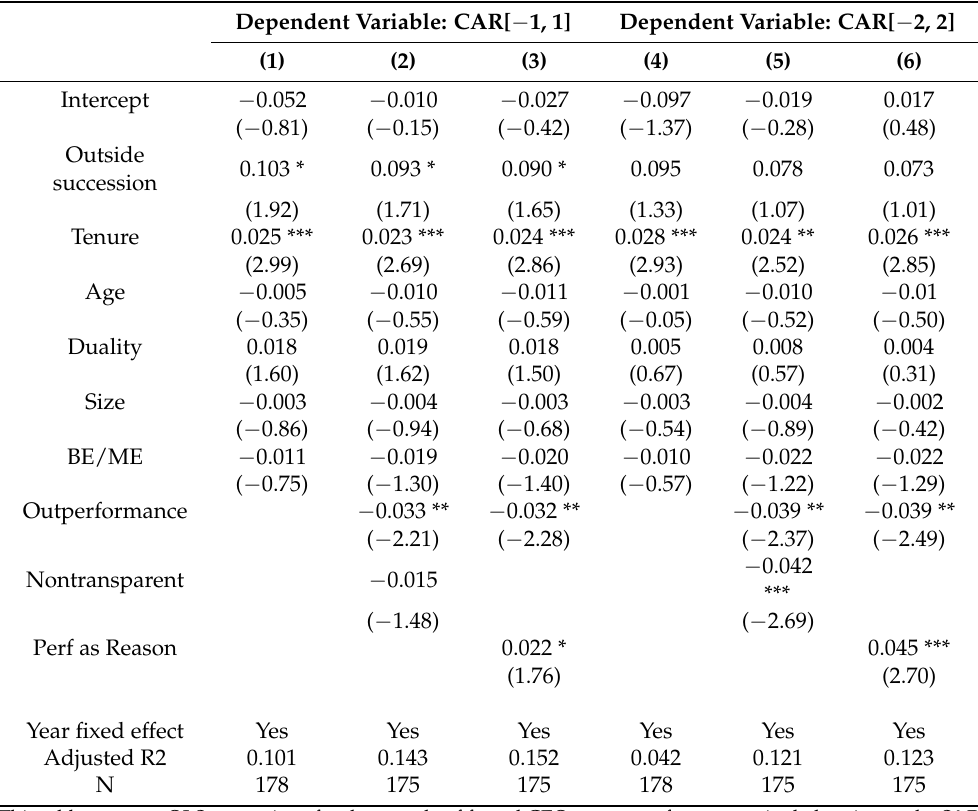
Table 5. Previous performance and official reasons of CEO dismissal impact on price reactions of forced CEO turnover